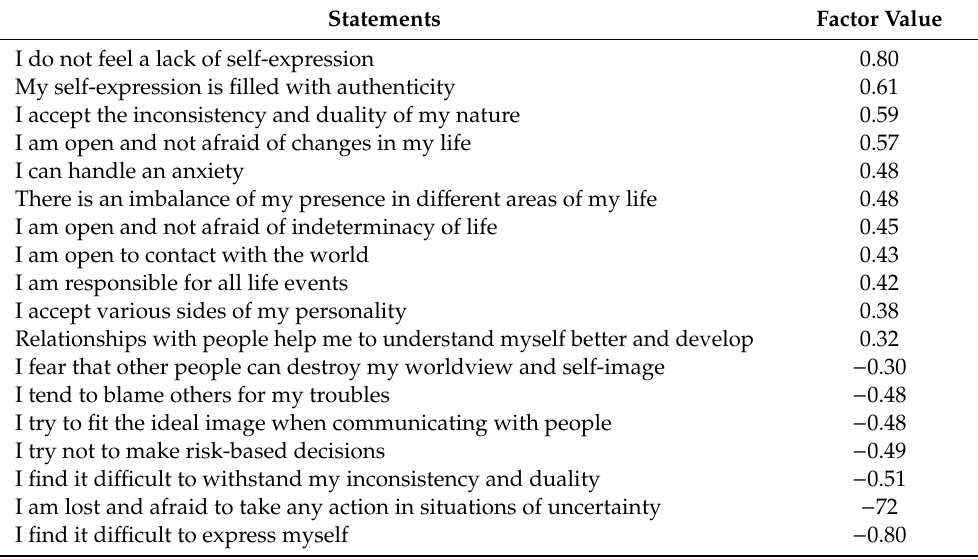
Table 4. Factor “Relationship with the